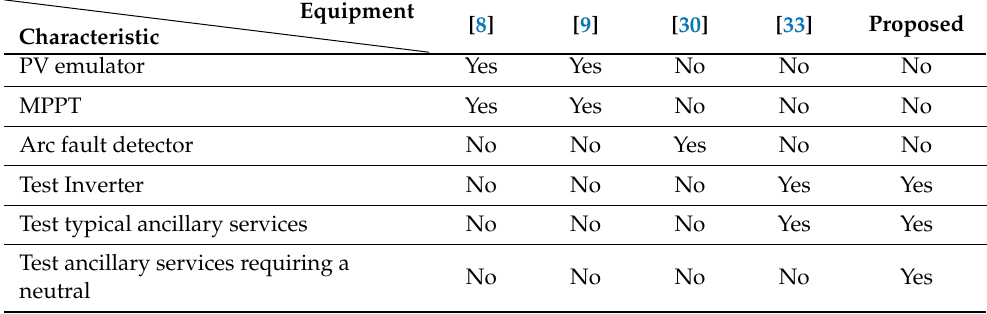
Table 3. Comparison of the proposed PV generator testing system with other developed